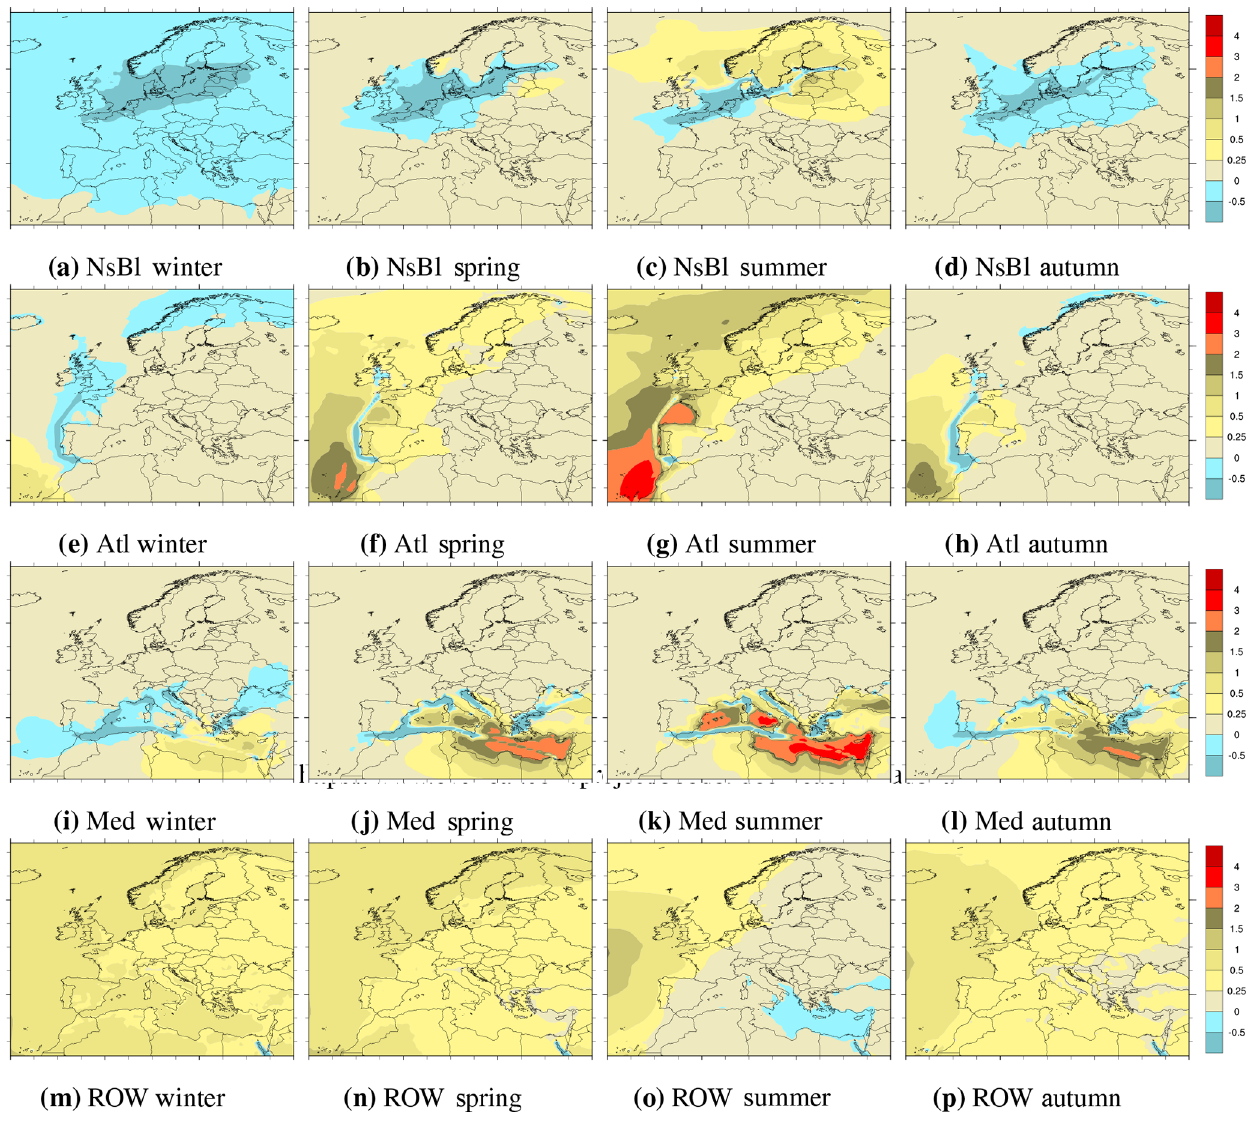
Figure 5. Seasonal contributions to European ozone levels (in ppb) from 15% perturbations of the emissions in separate sea areas defined contributions from shipping have been multiplied by 100 /